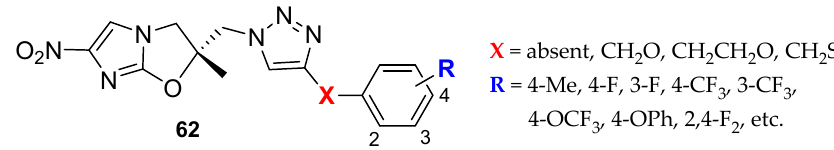
Figure 15. Truncated delamanid triazole analogues ( 62 ).